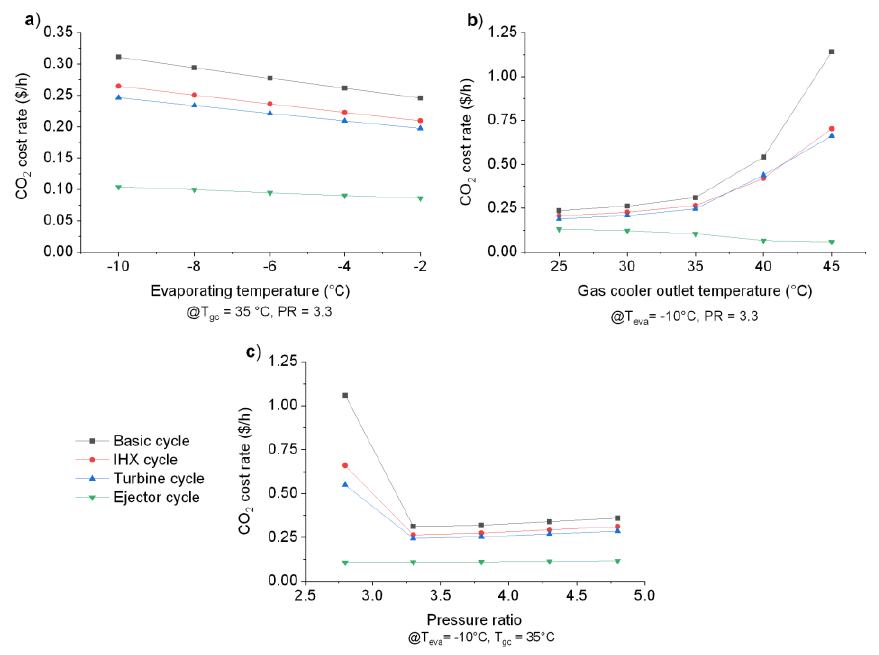
Figure 9. Variations of the CO 2 penalty cost rate due to the: ( a ) evaporating temperature; ( b ) gas cooler outlet temperature; ( c ) pressure ratio.